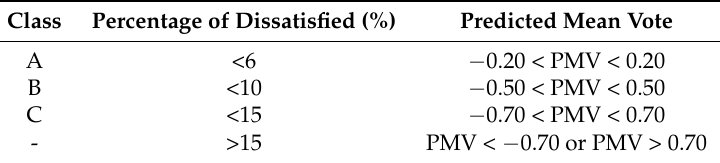
Table 2. Comfort classification based on